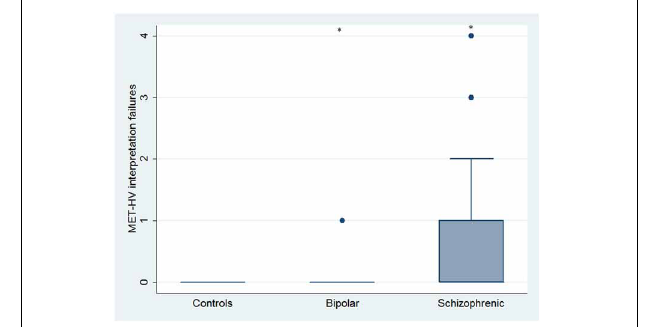
FIGURE 10 | Differences between groups in ESCB tasks: MET-HV Interpretation failures. • Outliers. ∗ Significantly different from HC ( p < 0 . 05).